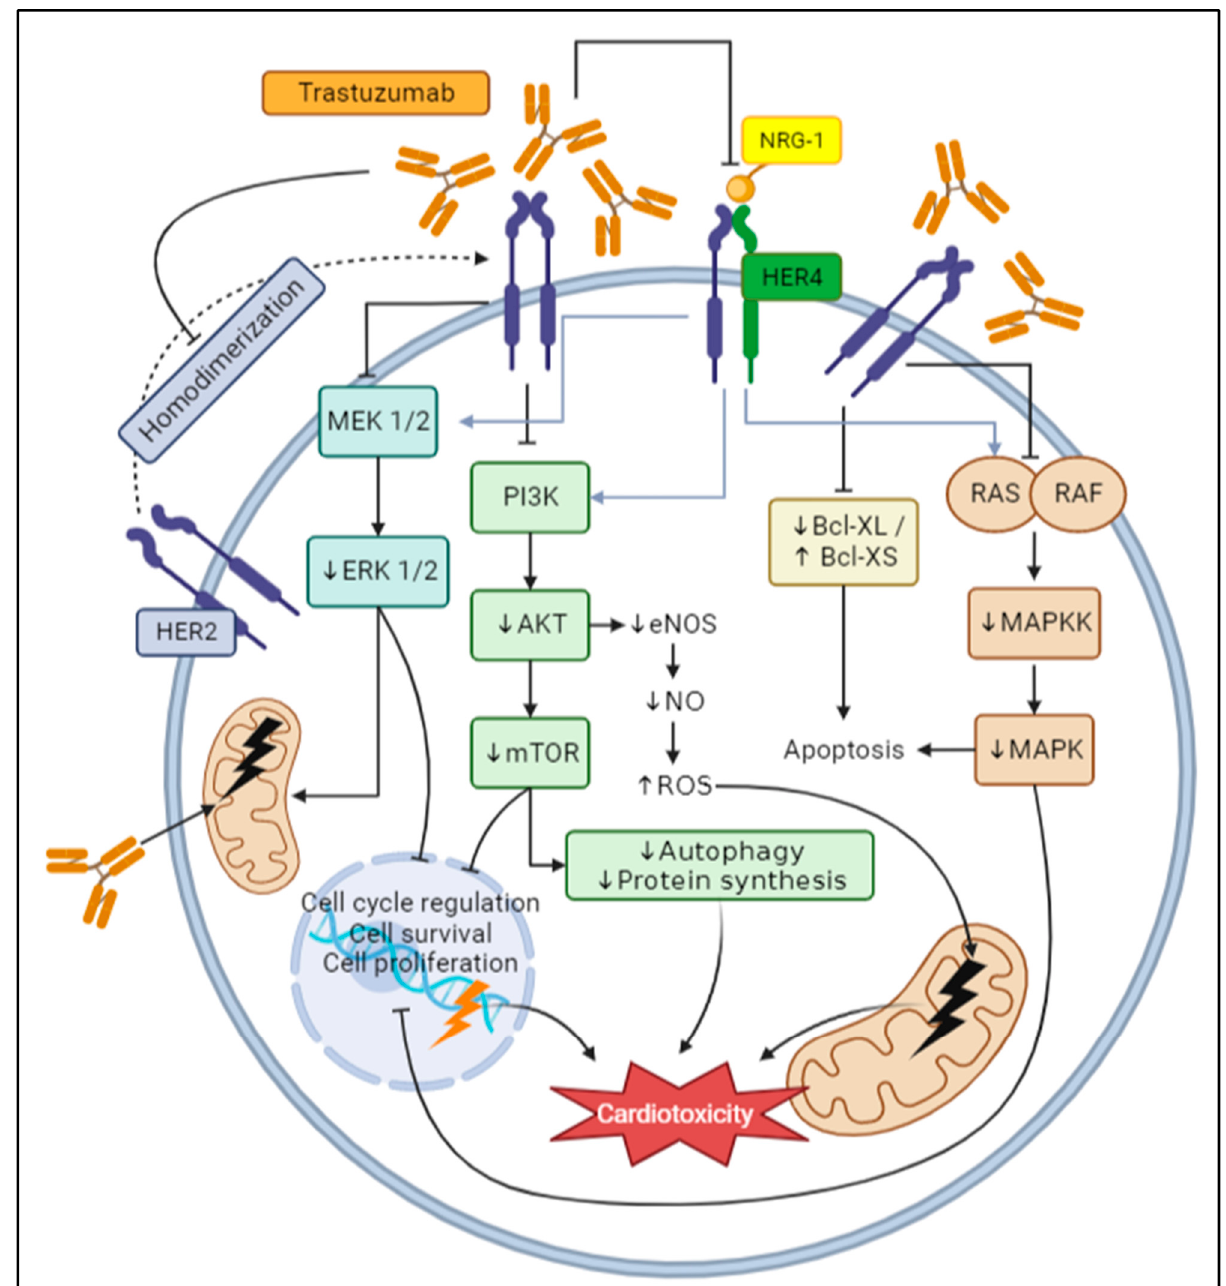
Figure 1. Molecular mechanisms of trastuzumab-induced oxidative stress in the cell. AKT, protein kinase B; Bcl-XL, B-cell lymphoma-extra-large; eNOS, endothelial nitric oxide synthase; ERK1/2, extracellular signal-regulated kinase 1/2; HER, human epidermal receptor; MAPK mitogen-activated protein kinase; MAPKK, MAPK kinase; MEK1/2 mitogen-activated protein kinase kinase 1/2; mTOR, mammalian target of rapamycin; NO, nitric oxide; NRG-1, neuregulin-1; PI3K, phosphoinositide 3-kinase; ROS; reactive oxygen species.